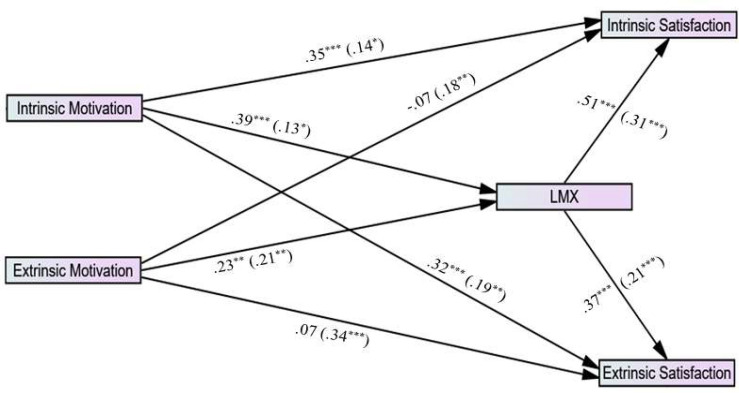
Path diagram for male group (n = 133) and female group (n = 217; in parenthesis), study 3. *p < 0.05, **p < 0.01, ***p < 0.001. χ2(df) = 5.17 (4), p = 0.461, χ2/df = 1.29, SRMR = 0.03, CFI = 0.94, GFI = 0.99, NFI = 0.95, ECVI = 0.21, RMSEA (90% CI) = 0.02 (0.00–0.07), p-close = 0.597.